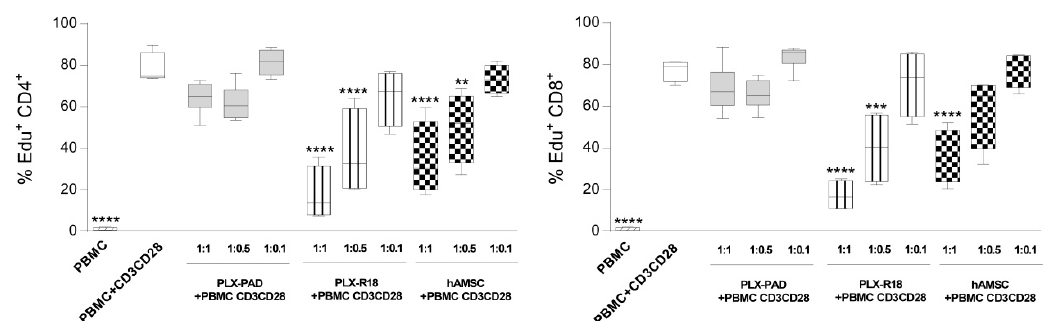
Figure 2. E ff ect of placental cells on T lymphocyte proliferation. Allogeneic PBMC (1 × 10 5 ) were stimulated with anti-CD3 / CD28 antibodies in the presence of decreasing ratios of maternal (PLX-PAD)-derived or fetal (PLX-R18 or hAMSC)-derived cells. Cells were cultured for three days, and proliferation was assessed by Edu (ethynyldeoxyuridine) incorporation added during the final 18 h of culture. Results are presented for both CD4 + and CD8 + T lymphocyte cell subsets and are expressed as a percentage of cell proliferation. PBMC stimulated with anti-CD3 / CD28 mAbs constitute the positive control while PBMC alone represent the basal level of proliferation. Results are displayed as mean ± SEM (** p < 0.01, *** p < 0.001, **** p < 0.0001 versus control PBMC + CD3CD28), n ≥ 4 individual experiments.